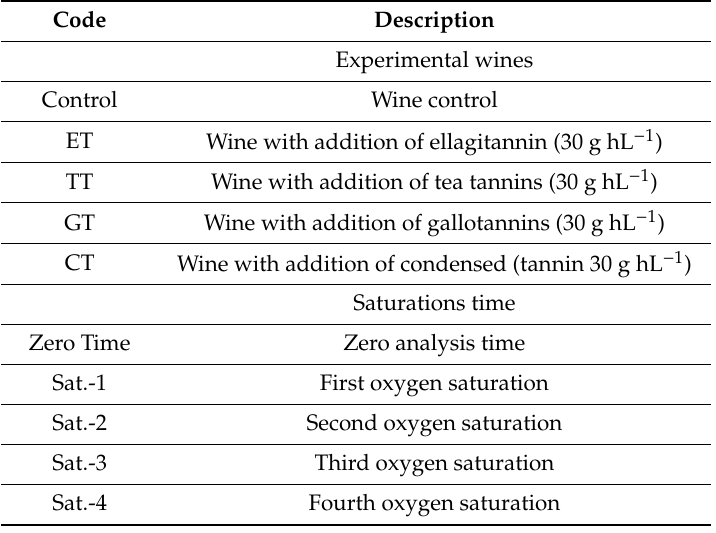
Table 4. Codes and description of experimental